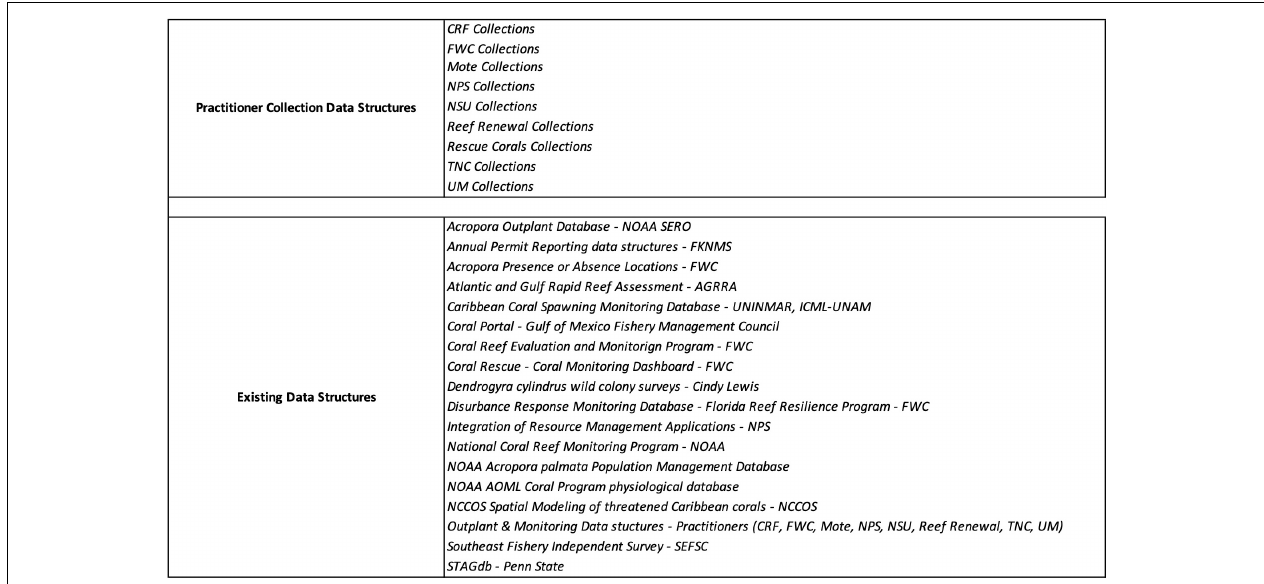
FIGURE 2 | A subset of coral data structures related to Florida coral restoration efforts. Practitioner Collection Data Structures represent those which will be used to populate the Coral Sample Registry, each sample being assigned an accession number. Existing Data Structures are representative examples of how coral data is used; this representative list is specific to Florida and the Caribbean and not intended to be exhaustive of what may